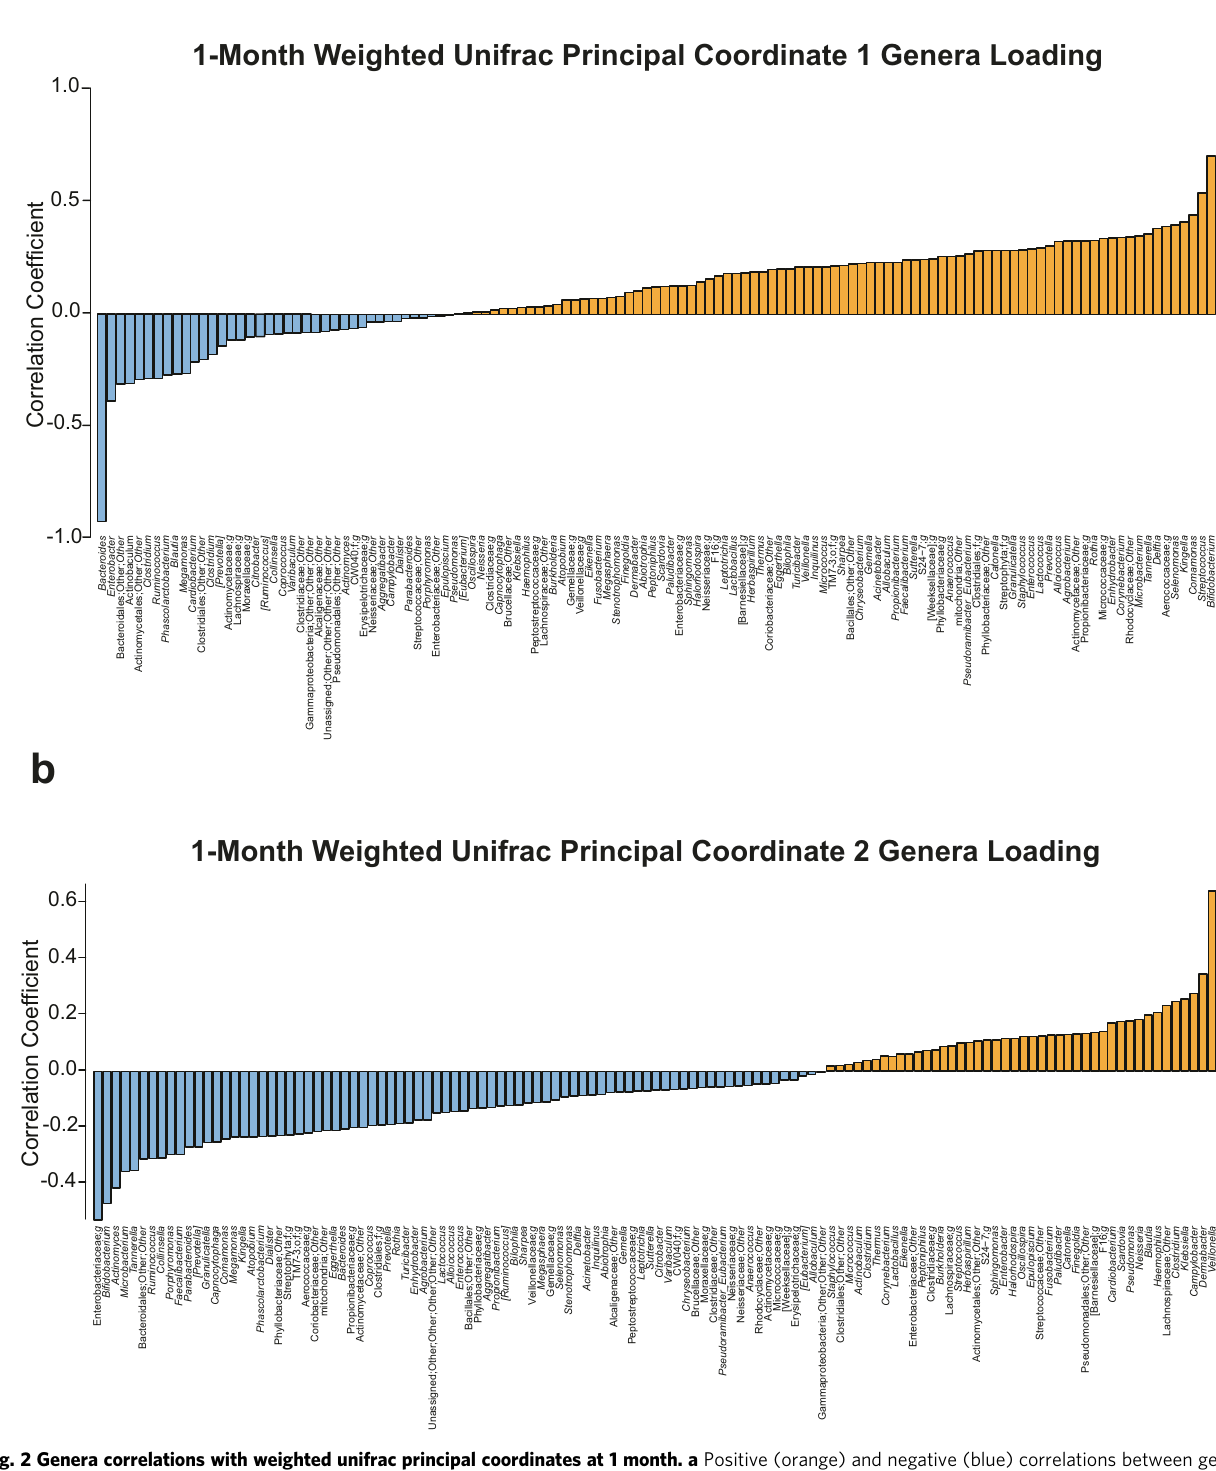
Fig. 2 Genera correlations with weighted unifrac principal coordinates at 1 month. a Positive (orange) and negative (blue) correlations between genera and beta diversity metric, Weighted Unifrac principal coordinate 1 at 1 month of age. b Positive (orange) and negative (blue) correlations between genera and beta diversity metric, Weighted Unifrac principal coordinate 2 at 1 month of age. Source data for this fi gure are provided as a Source Data fi